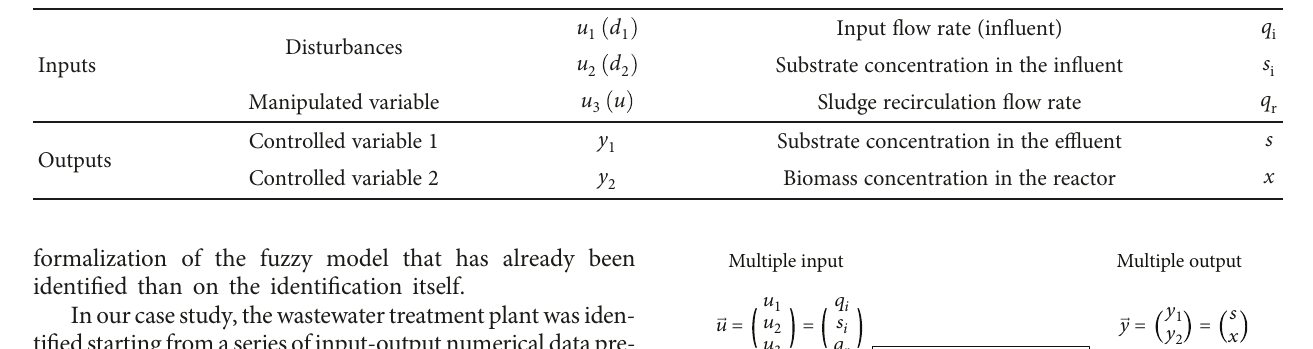
Table 2: Inputs and outputs of the wastewater treatment